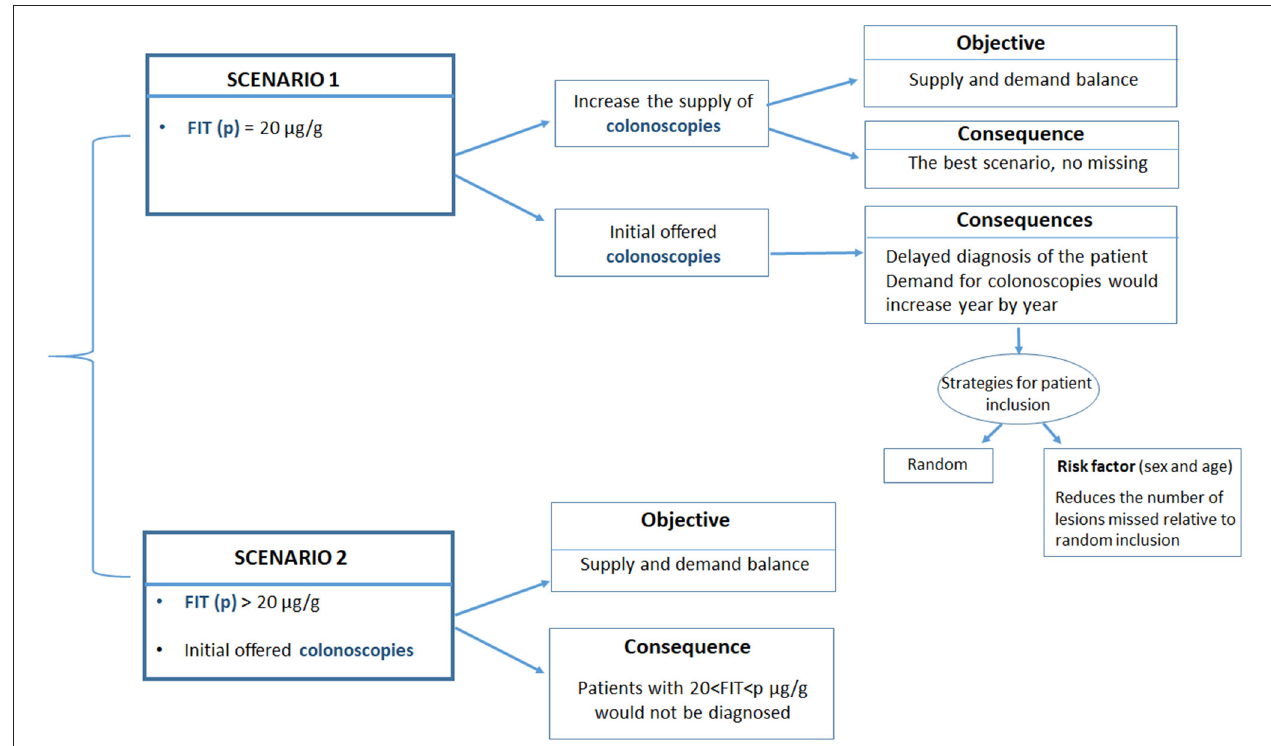
FIGURE 1 | Description of the two scenarios analyzed in the current study. Scenario 1 maintains the current FIT cut-off point (20 µ g hemoglobin/g feces), regardless of the annual demand for colonoscopies. Scenario 2 increases the current FIT cut-off point to match the number of colonoscopies to the expected number of positive cases for a given number of